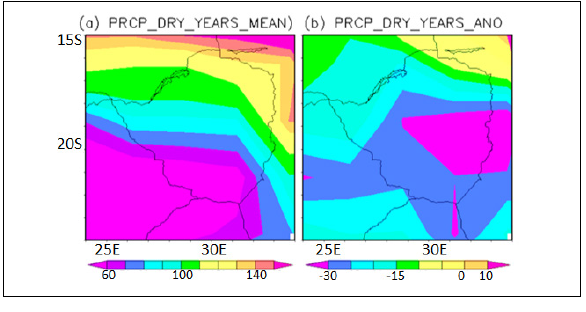
Figure 9: (a) Mean and (b) anomaly maps for rainfall distribution (in mm) over Zimbabwe for six dry years for the December– February months.